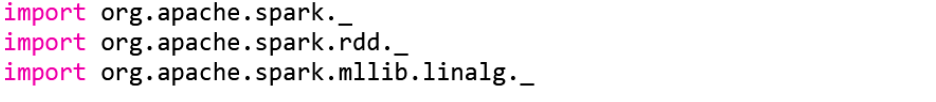
Figure 8. getFeatureVectors() for creating purely numerical feature vectors.